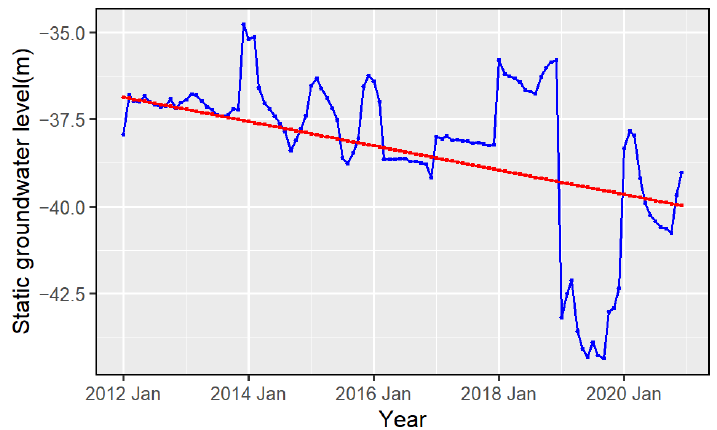
Figure 8. Time-series of static groundwater levels in Tajpura.